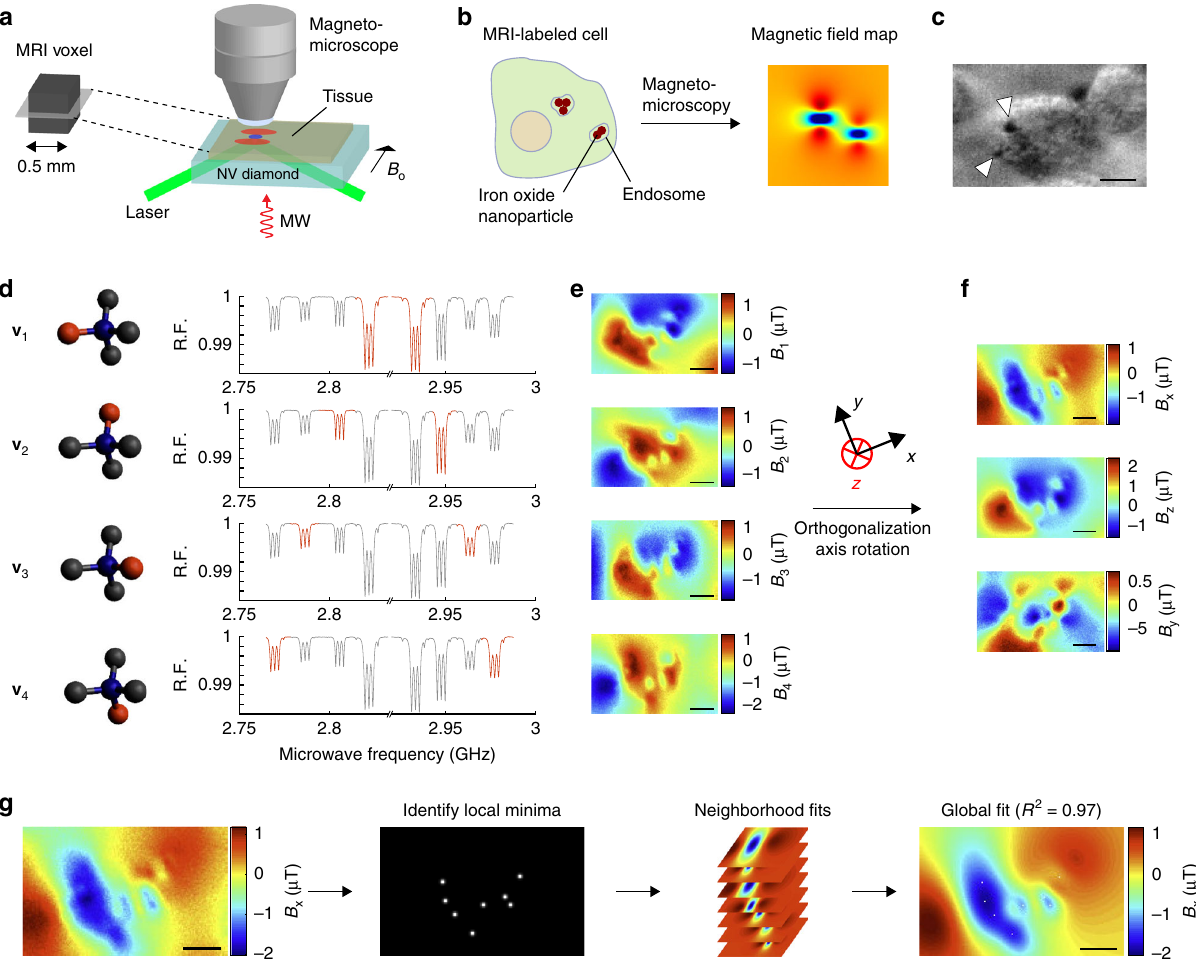
Fig. 1 Subcellular mapping of magnetic fi elds in cells labeled for MRI. a Schematic of subvoxel magnetic fi eld mapping using a NV magneto-microscope. b Illustration of a cell labeled with IONs and its expected magnetic fi eld pattern. c Bright- fi eld image of RAW 264.7 macrophage labeled with 200- nm IONs. White arrows point to internalized IONs. A bright- fi eld imaging artifact also appears as black in the upper right corner of the cell. d Cartoon representation of each NV orientation and the corresponding representative spectra from fi xed-cell experiments. The blue ball represents nitrogen and the red ball represents the adjacent lattice vacancy. Highlighted peaks in each relative fl uorescence (RF) spectrum show the transition corresponding to each of the four orientations. e Magnetic fi eld images of the fi eld projections along each of the four NV axes of macrophages 2 h after initial exposure to 279 ng ml − 1 200- nm IONs. f Images in e converted via Gram – Schmidt orthogonalization and tensor rotation to fi eld maps along three Cartesian coordinates with the z axis de fi ned perpendicular to the diamond surface and the x axis de fi ned as the projection of the applied bias fi eld onto the diamond surface plane. The y axis is de fi ned to complete the orthogonal basis set. g Representative example of the procedure for dipole localization in cellular specimens. This procedure comprises three steps: fi rst the local minima in the fi eld map are identi fi ed and ranked; next, in decreasing order of magnitude, the neighborhood of each local minimum is fi t to a point dipole equation and the resulting fi eld is subtracted from the fi eld map to reduce the fi t-deleterious effect of overlapping dipole fi elds; and fi nally, the results of these fi ts are used as guess parameters for a global fi t over the full fi eld of view. The fi t shown has a degree-of- freedom-adjusted R 2 of 0.97. Scale bars are 5 µ